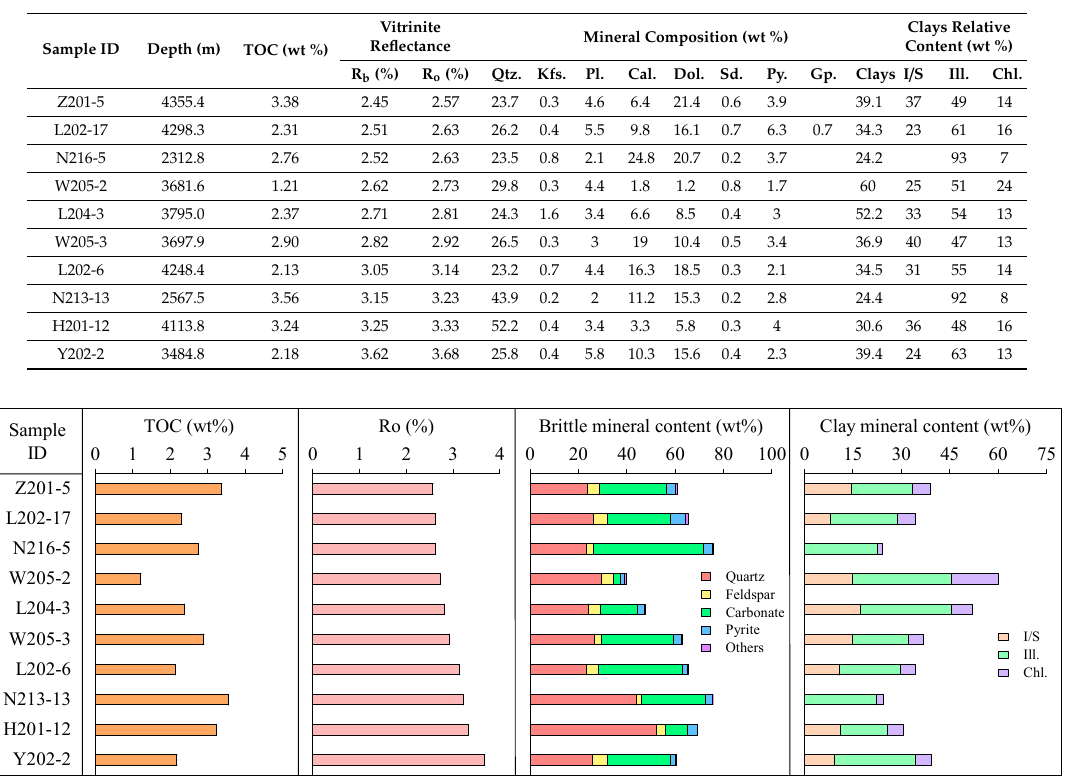
Table 1. Total organic carbon (TOC) content, thermal maturity and mineral composition of Longmaxi shale (Qtz.: Quartz; Kfs.: K ‐ feldspar; Pl.: Plagioclase; Cal.: Calcite; Dol.: Dolomite; Sd.: Siderite; Py.: Pyrite; Gp.: Gypsum; I/S, illite/smectite mixed layer; Ill., Illite; Chl., Chlorite).